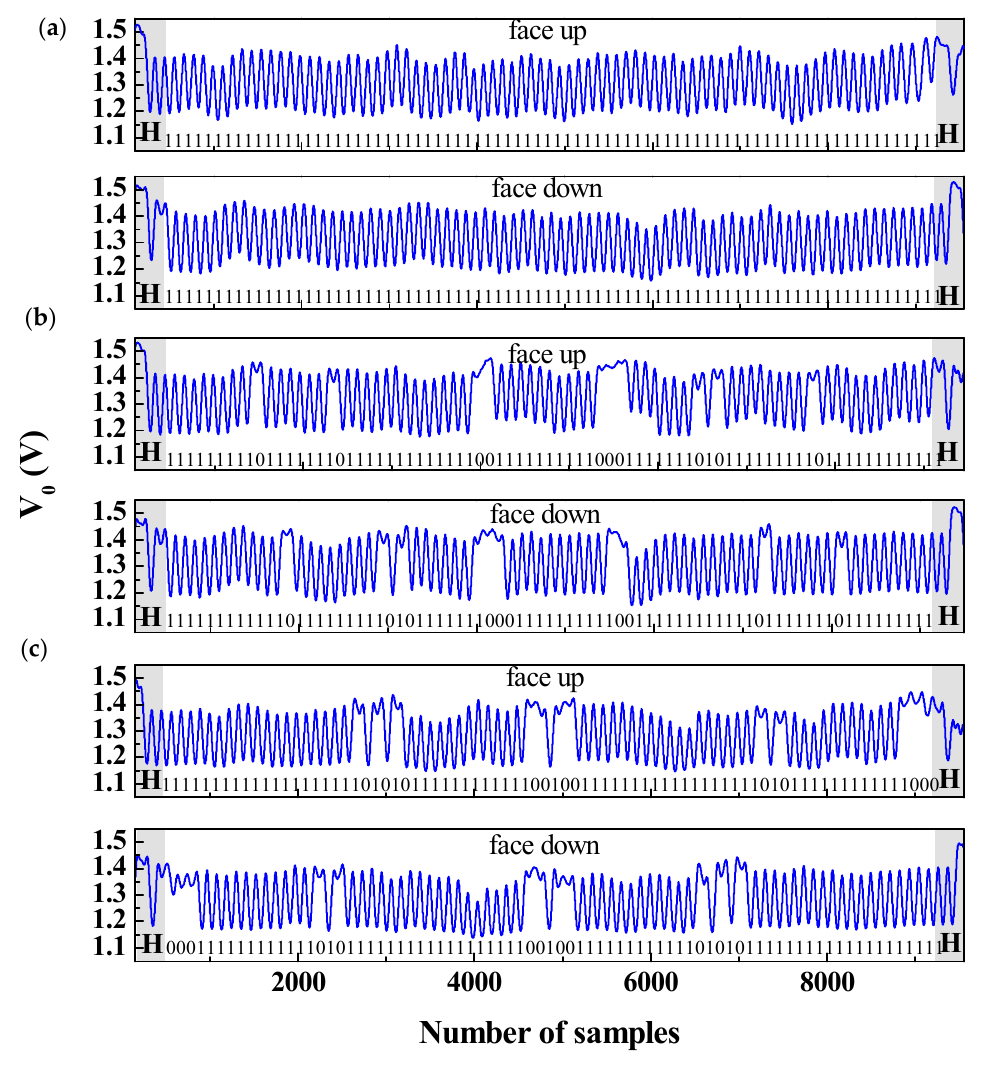
Figure 6. Measured envelope functions of the inkjet-printed 80-bit tag with the indicated codes. Because the envelope function has been inferred from a data acquisition system, the abscise axis is the number of samples. Note that there is no difference in the reading results between face-up and face-down tags. The codes are read in opposite directions for face-up or face-down tags, but this is indicated by the header bits and, therefore, there is no confusion regarding this aspect. ( a ) code with all bits set to ‘1’ logic state, ( b ) programmed tag and ( c ) reprogrammed tag .